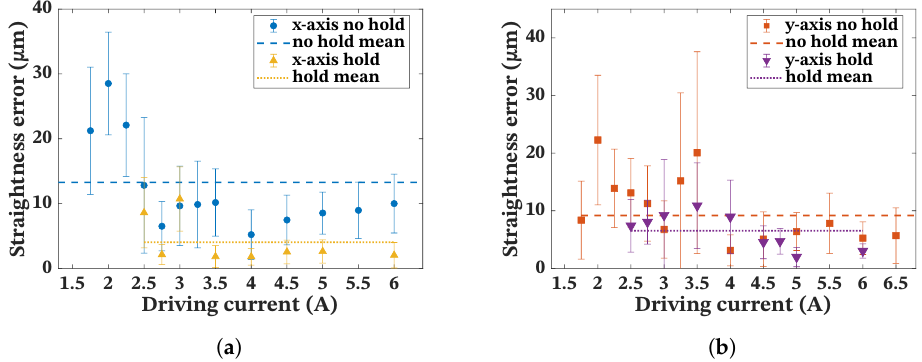
Figure 10. Holding current influence on straightness error. ( a ) x -axis results. ( b ) y -axis